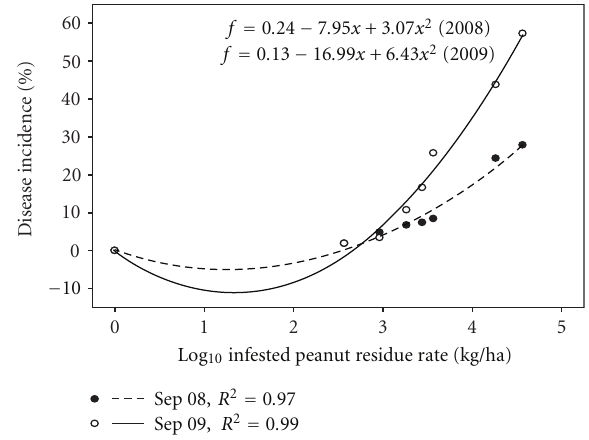
Figure 3: E ff ect of infested peanut residue rates on Verticillium wilt incidence (%). Infested peanut residue rates 0, 370, 925, 1850, 2775, 3700, 18495, and 37000 kg/ha were log 10 transformed and were expressed as 0, 2.6, 3.0, 3.3, 3.4, 3.6, 4.3, and 4.6 on X -axis. Linear quadratic equation f = y 0 + ax + bx 2 was used to calculate intercept ( y 0 ), slope (a) and curvature